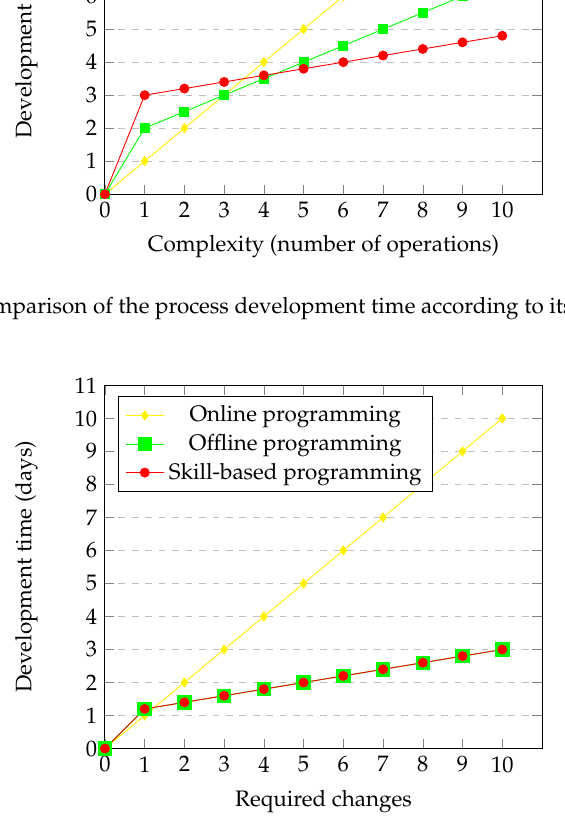
Figure 15. Comparison of the process development time according to the number of adjustments in element positions.